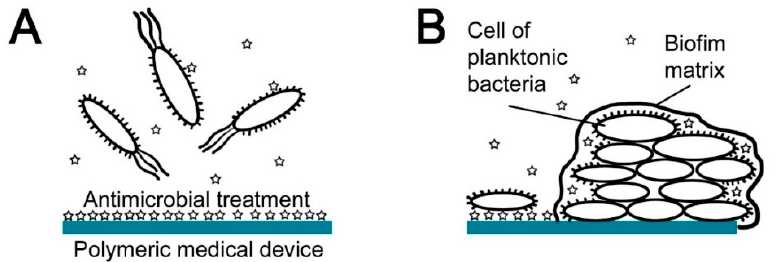
Figure 3. Effects of antimicrobial treatment of polymeric medical devices: ( A ) prevention of bacterial adhesion; ( B ) inhibition of bacterial colonization (preclusion of biofilm formation).